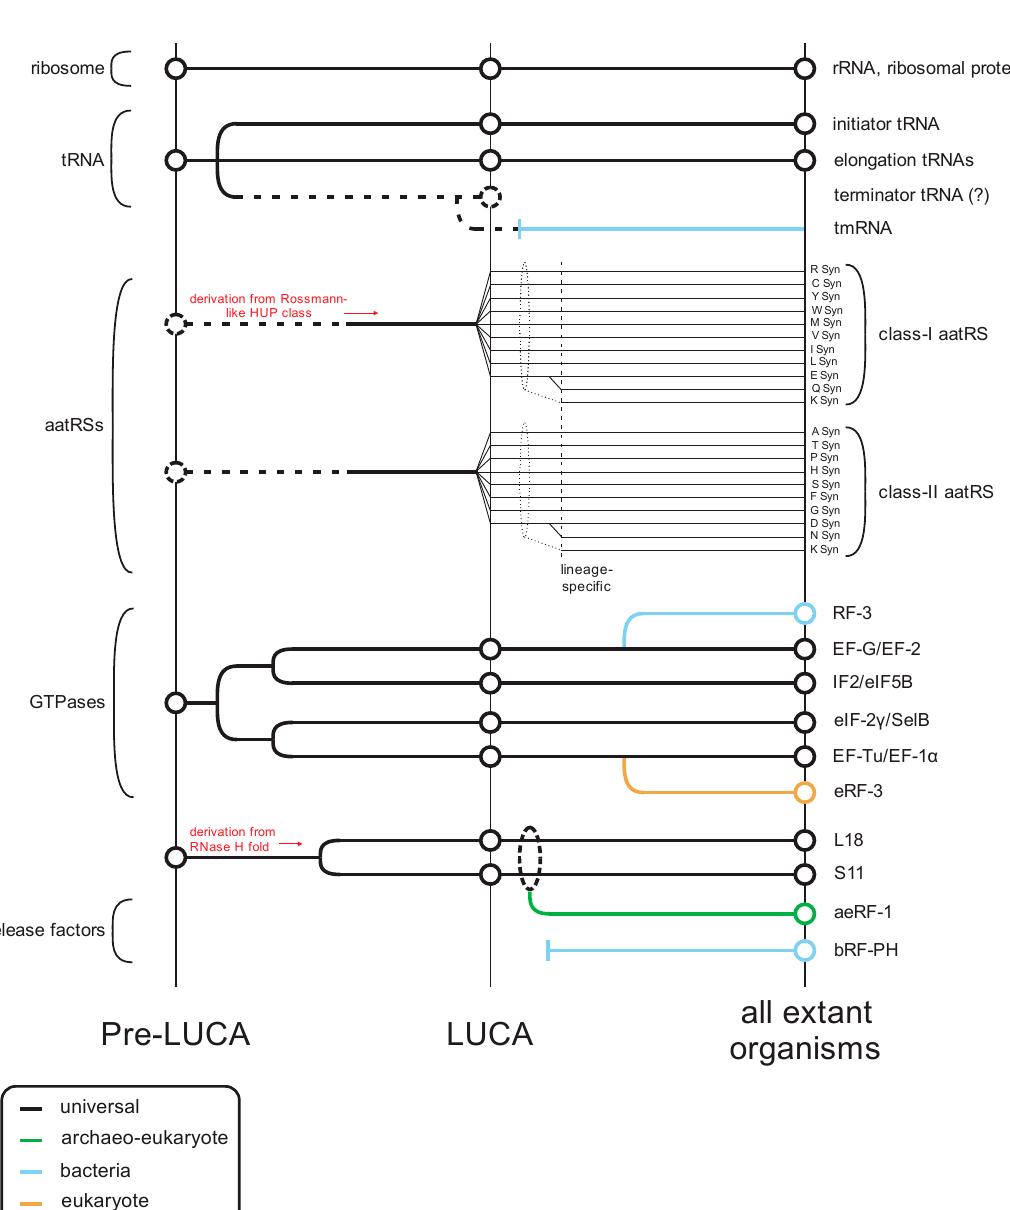
Figure 1. Overview of the evolutionary history of the translation apparatus. Key classes of protein and RNA contributors (general protein/RNA class labeled to the left , specific component names provided to the right ) in translation are traced across several evolutionary epochs (labeled at the bottom ) in this temporal diagram. Lines track evolutionary depth for components and are color-coded by phyletic distribution. Key derivation events are noted in red. Events where evolutionary depth are unclear are denoted with broken lines.